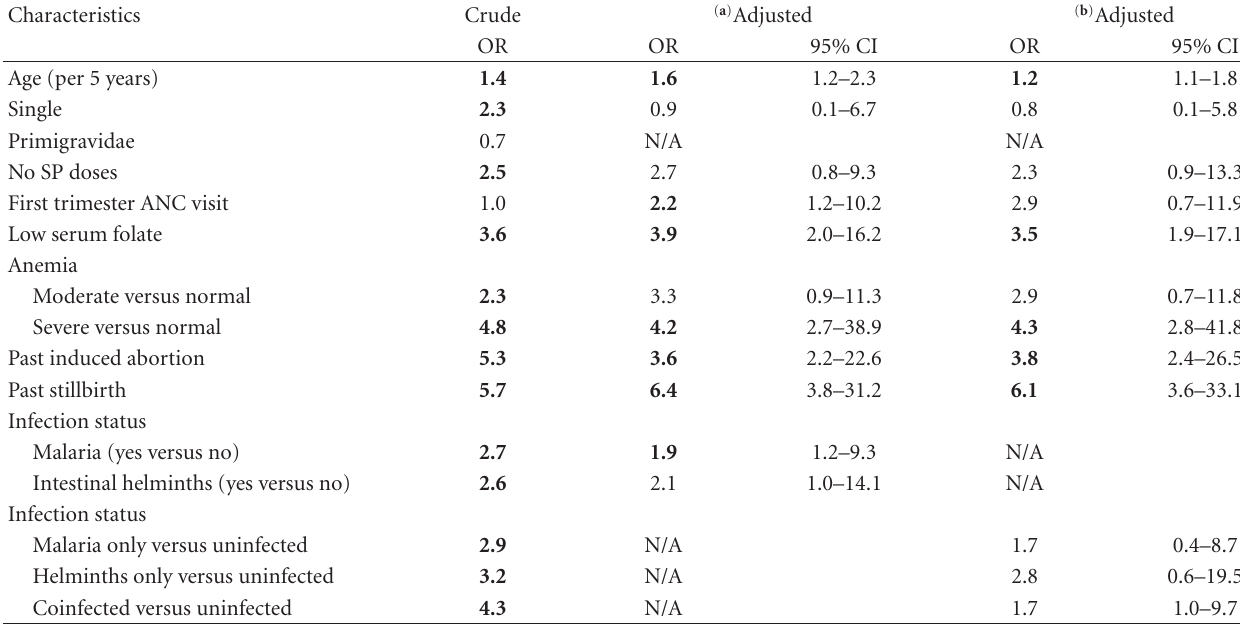
Table 3: Risk factors associated with stillbirth in Ghana,